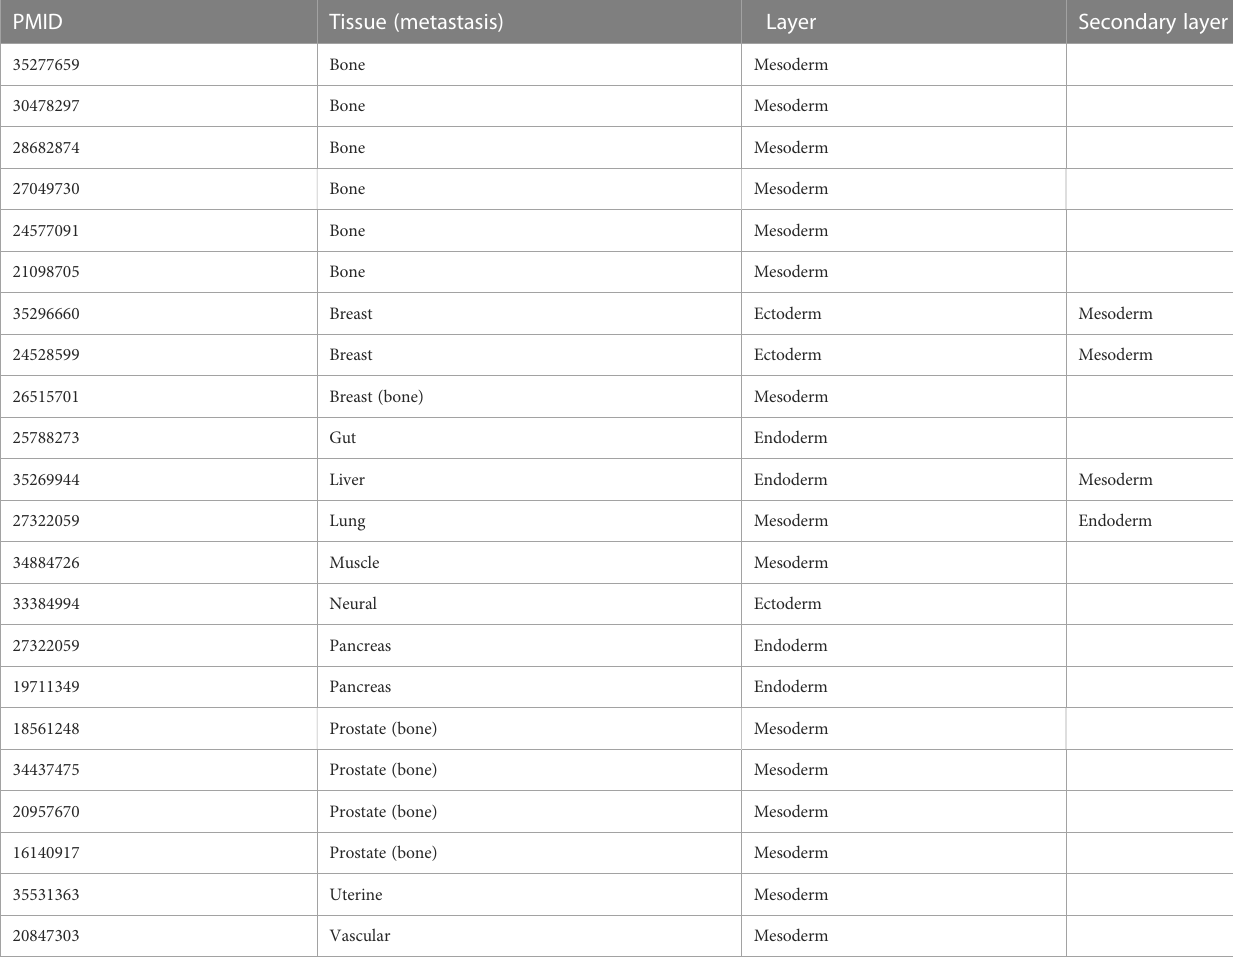
TABLE 1 List of studies where Dkk-1 is reported as a tumor driver.